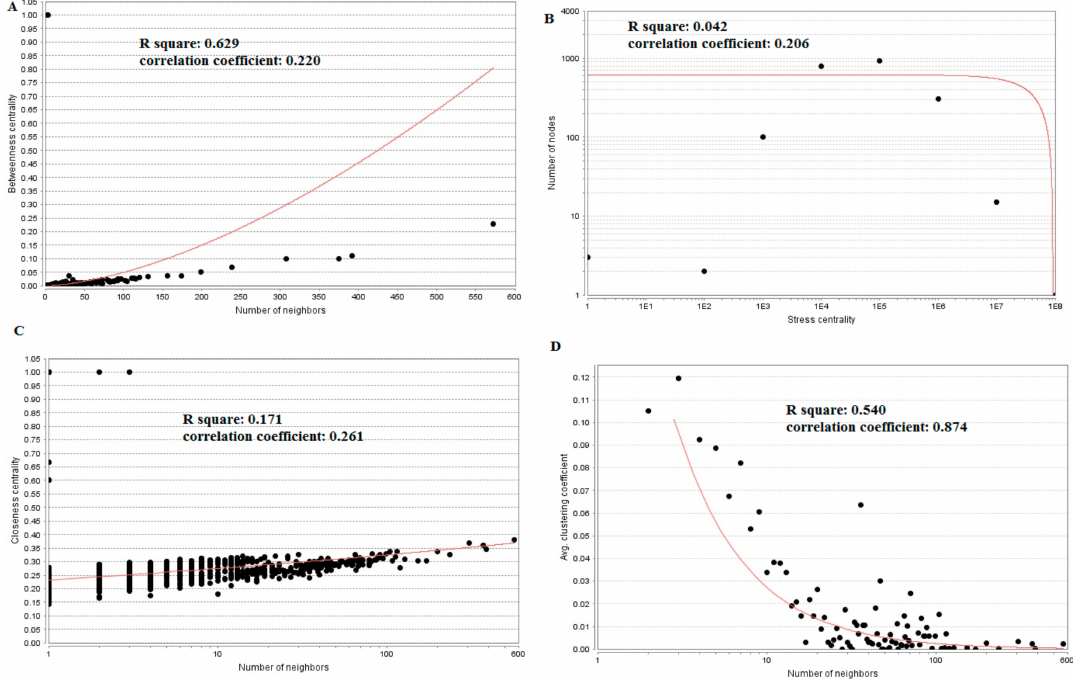
Figure 10. Regression diagrams for down-regulated genes ( A ) Betweenness centrality; ( B ) Stress centrality; ( C ) Closeness centrality; ( D ) Clustering coe ffi